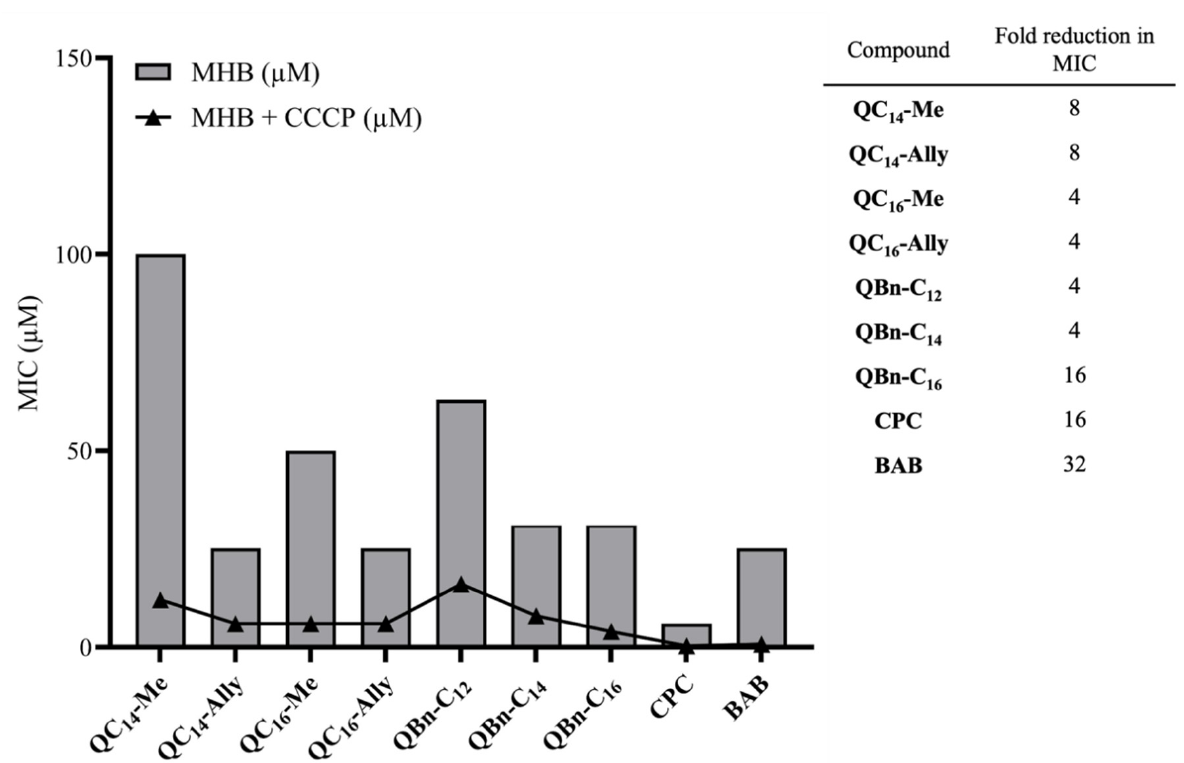
Figure 4. The potential for bacterial resistance development for 3-amidoquinuclidine quaternary ammonium compounds (QACs) and commercial QACs, cetylpiridinium chloride (CPC), and benzyldodecyldimethylammonium bromide (BAB). The obtained MIC values in Mueller–Hinton broth (MHB) are shown as bars in µ M values compared to the MIC obtained in the presence of carbonyl cyanide 3-chlorophenylhydrazone (CCCP) (line). The bar graph is accompanied by a table showing the MIC reduction by the factor.